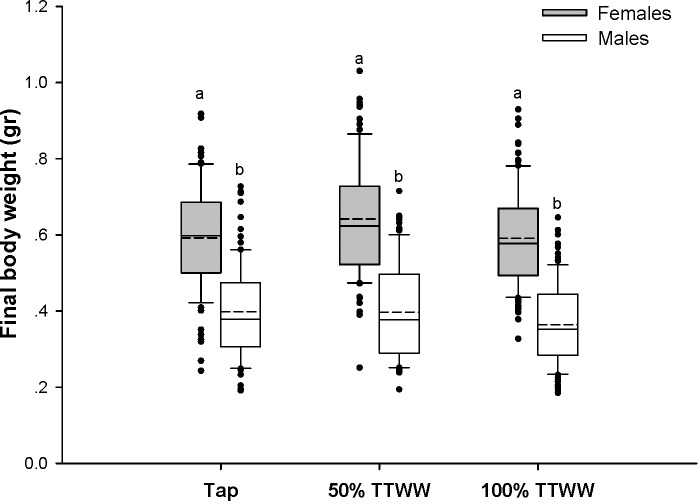
Final body weight (grams) of male and female guppies raised in different water treatments.Results presented as mean (dashed line), median (solid line), 25th and 75th percentiles (edges of boxes), 10th and 90th percentiles (whiskers), and outliers (dots). The a, b letters denote significant differences between males and females within each treatment groups (p < 0.05).